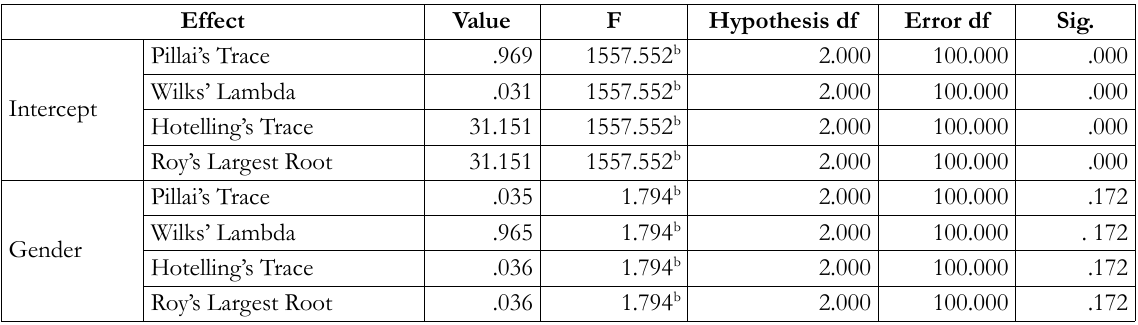
Table 3. MANOVA of Gender Prediction between Students’ Further Mathematical Ability and their performance in Physics